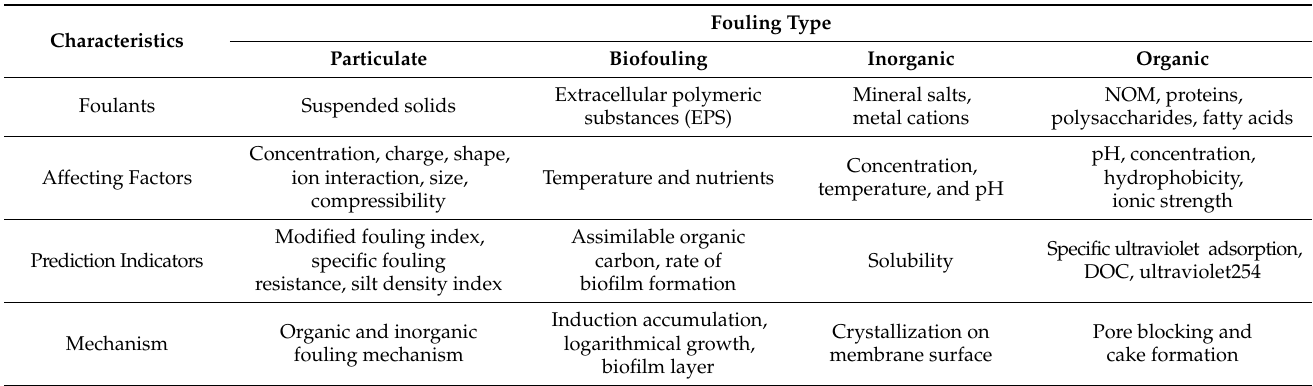
Table 4. Different foulants and their characteristics